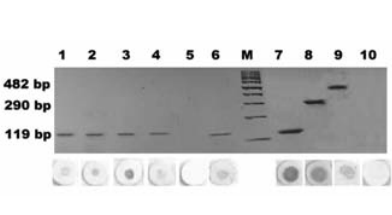
Figure 2. Samples of A. aegypti larvae sub- mitted to Multiplex reverse transcriptase- polymerase chain reaction and immun- odot blot. 1 to 6: samples of larvae, M: 100-bp ladder, 7: positive dengue virus (DENV)-2 control, 8: positive DENV-3 control, 9: positive DENV-1 control; 10: dengue negative larvae